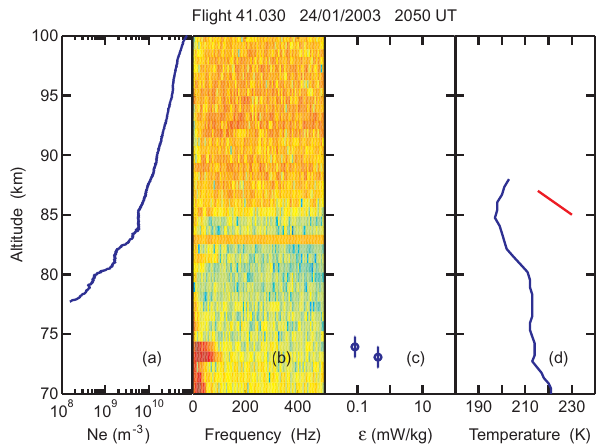
Fig. 6. Same as Fig. 2 except data obtained 24 January 2003, 20:50 UT (Flight 41.030), from Esrange, Sweden. Note the change of the temperature range (panel